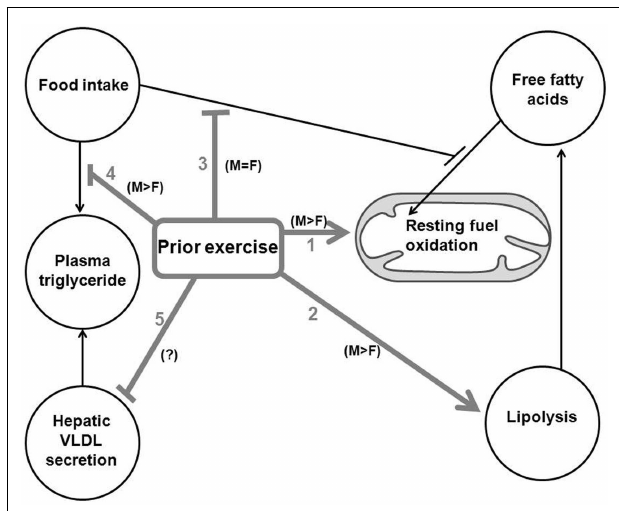
FIGURE 1 | Summary of the effects of an acute endurance exercise bout on subsequent metabolism of lipids in the support of the resting metabolic rate is shown . M > F, response of males greater than that of females to a recent exercise bout. M = F, responses similar between males and females to a recent exercise bout. ?, Results for investigations of sex differences not yet reported. 1, recent exercise increases subsequent RMR (total substrate oxidation) in men but not significantly in women. 2, Exercise increases subsequent post-absorptive whole-body lipolysis in men but not in women.This higher lipolysis in men increases availability of FFA, which causes greater accentuation of post-absorptive fat oxidation in men than women. 3, Food intake generally inhibits subsequent fat oxidation, such that postprandial lipid oxidation is lower than post-absorptive lipid oxidation, but prior exercise blunts this inhibition of fat oxidation; thus, postprandial fat oxidation is enhanced by a recent exercise bout (similarly in men and women). 4, Food intake leads to transient elevation of plasmaTG concentration (postprandial lipemia), but recent exercise blunts postprandial lipemia, likely to a greater extent in men than women. 5, Prior exercise blunts hepaticVLDL-TG secretion, but the sex difference is not yet clearly defined in the